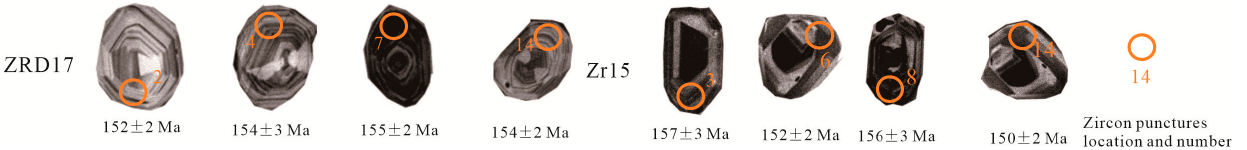
Figure 3. Representative CL images and ages of zircons from Late Jurassic mafic volcanic rocks.